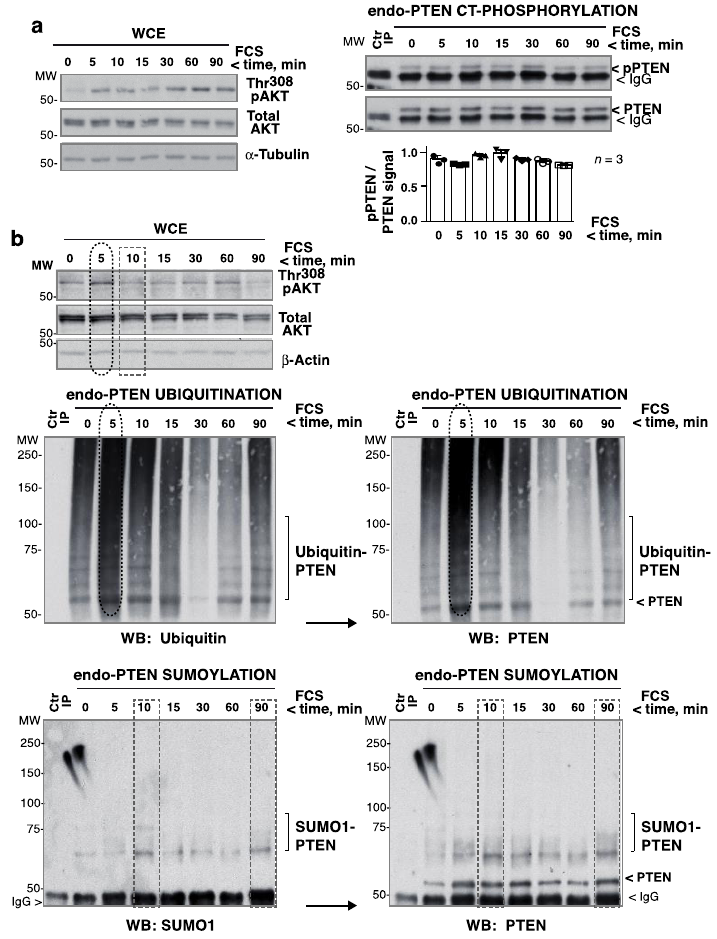
Figure 4. Maximum pAKT levels correlate with PTEN ubiquitination. ( a ) HEK-293T cells were incubated in medium without serum (2 h), and then stimulated with FCS (15%) for different times. Left blots show Thr308pAKT levels in WCE. Extracts (1 mg) were also incubated with anti-PTEN Ab for IP and pPTEN levels determined in WB (right panels). For controls (Ctr), extracts were incubated with Prot A. The graph shows the normalized pPTEN signal (corrected for PTEN levels) with respect to the mean pPTEN signal (considered 1) (mean ± SD, n = 3). ( b ) HEK-293T cells were activated as in ( a ); Thr308pAKT levels were examined in WCE (top panels). Extracts were also enriched for ubiquitinated proteins in TUBES columns. The eluted extracts were incubated with PTEN Ab-beads for IP and these examined by WB (top left). Secondary PTEN blots confirmed the retention of more ubiquitinated-PTEN at 5 min in the TUBES columns (right). PTEN was also immunoprecipitated from WCE and its sumoylation examined by WB. Subsequent PTEN blots showed the efficiency of PTEN IP. For controls, extracts were incubated with control beads. Maximum ubiquitination (ellipses) and sumoylation (rectangles) are